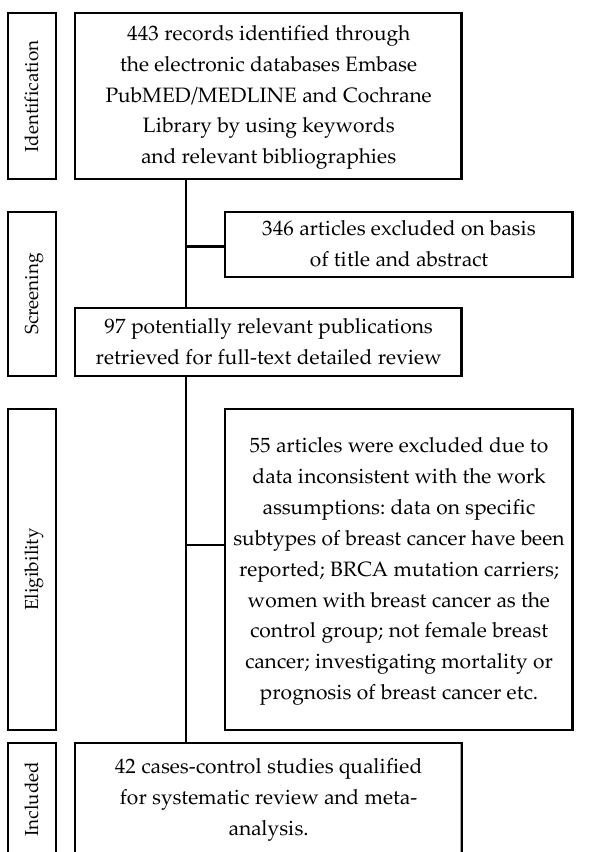
Figure 1. Flowchart of the selection procedure for studies included in the current review and meta ‐ analysis. Table 1. Characteristics of the case ‐ control studies included in the meta ‐ analysis on the association between OC use and BrCa risk.